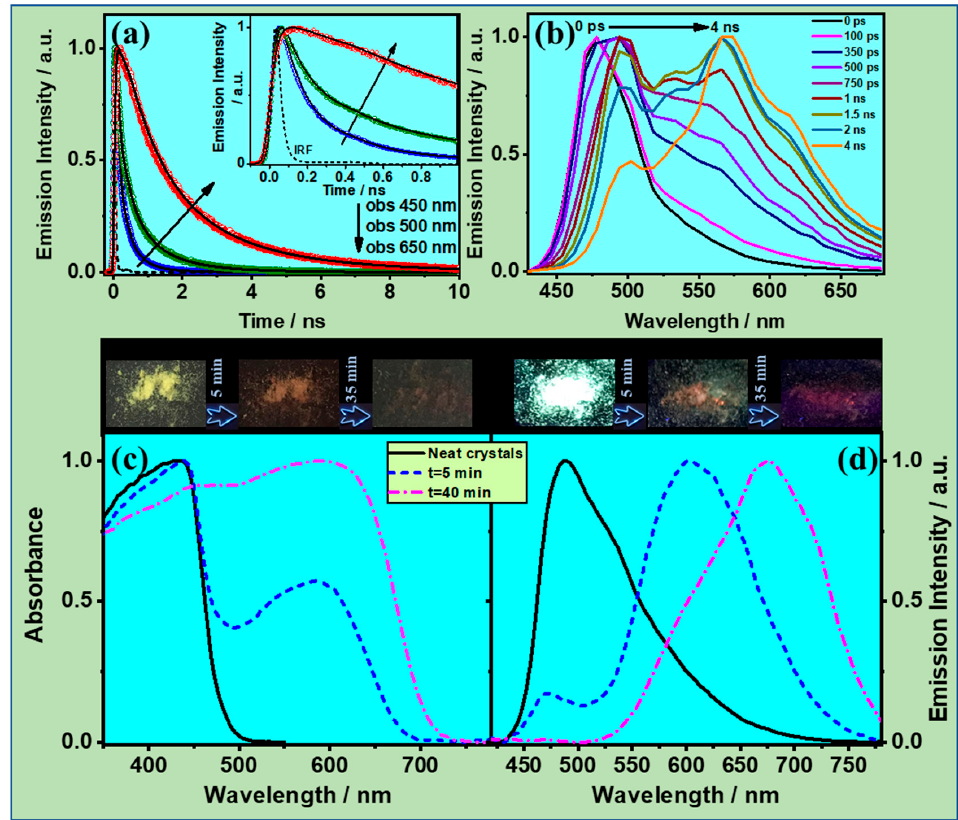
Figure 10. ( a ) Emission decays of solid CBPHAT-1a, recorded at the indicated wavelengths. The dashed signal is the IRF of the setup. ( b ) Normalized TRES of CBPHAT-1a in the solid-state at the indicated gating time. ( c ) Absorption and ( d ) emission spectra of CBPHAT-1a crystals before and after exposure to HCl atmosphere. The upper pictures in ( c , d ) show the color of the crystals before and after interaction with HCl atmosphere in ambient light and upon irradiation with a 360 nm lamp.